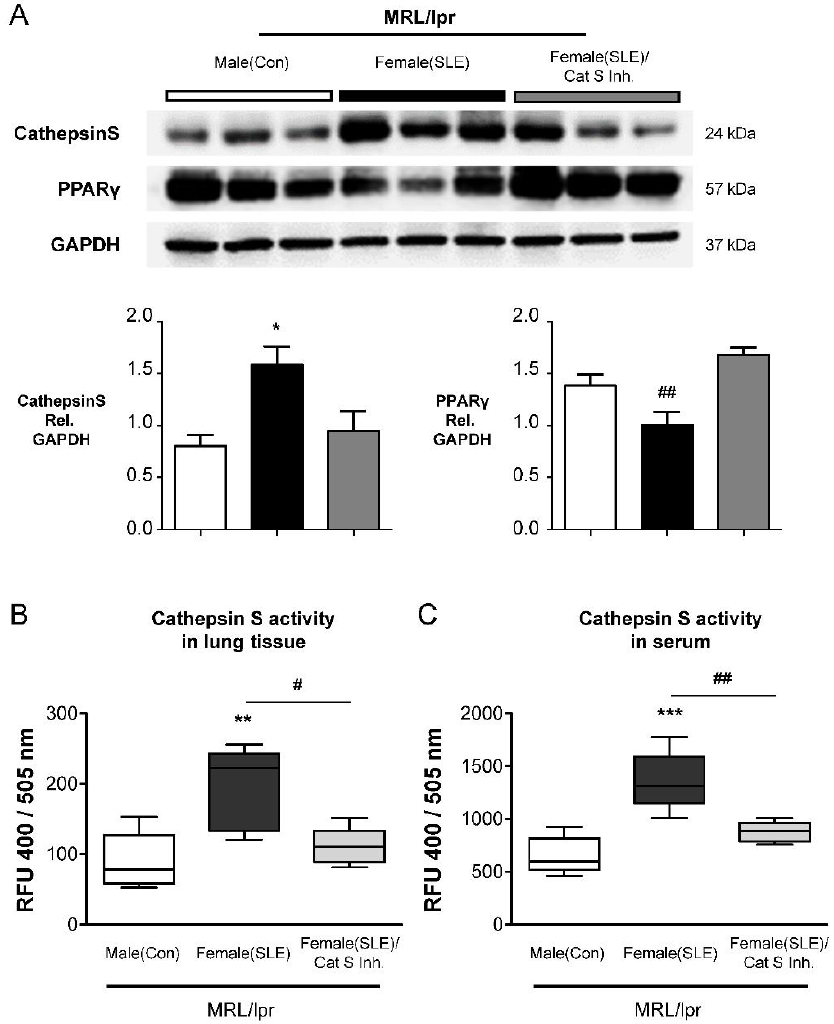
Figure 4. Effect of Cat S inhibitor on PPAR γ stimulation, and decreasing Cat S expression in the lungs and circulation of female MRL/lpr mice. ( A ) Representative immunoblotting densitometry quantification of protein expression is indicated for the lungs of the three groups. Cat S (24 kDa band) and PPARγ (57 kDa band). The bars represent the mean ± SEM for n = 3 samples. * p < 0.05 (increase) or ## p < 0.05 (decrease) compared with the male MRL/lpr mice (Con) group. ( B ) Cat S activity in the lung tissue lysate. ( C ) Cat S activity in the serum. Each value (mean ± SE ( n = 6 – 7) is expressed. ** p < 0.01, *** p < 0.001 (increase) versus male MRL/lpr (Con) mice, or # p < 0.05, ## p < 0.01 (decrease) compared with the female MRL/lpr mice, one-way ANOVA, Bonferroni posttest.